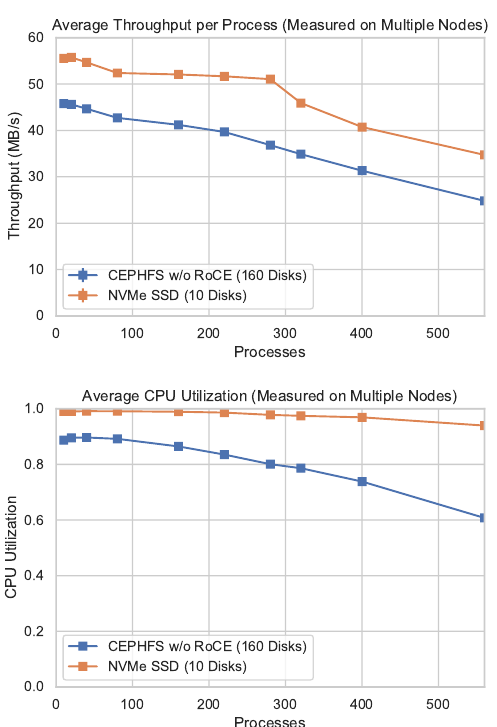
Figure 2. Results of the reading benchmark performed on the TOpAS worker nodes. The average throughput of the storage per process accessing it is shown at the top and the average CPU utilization for the processes at the